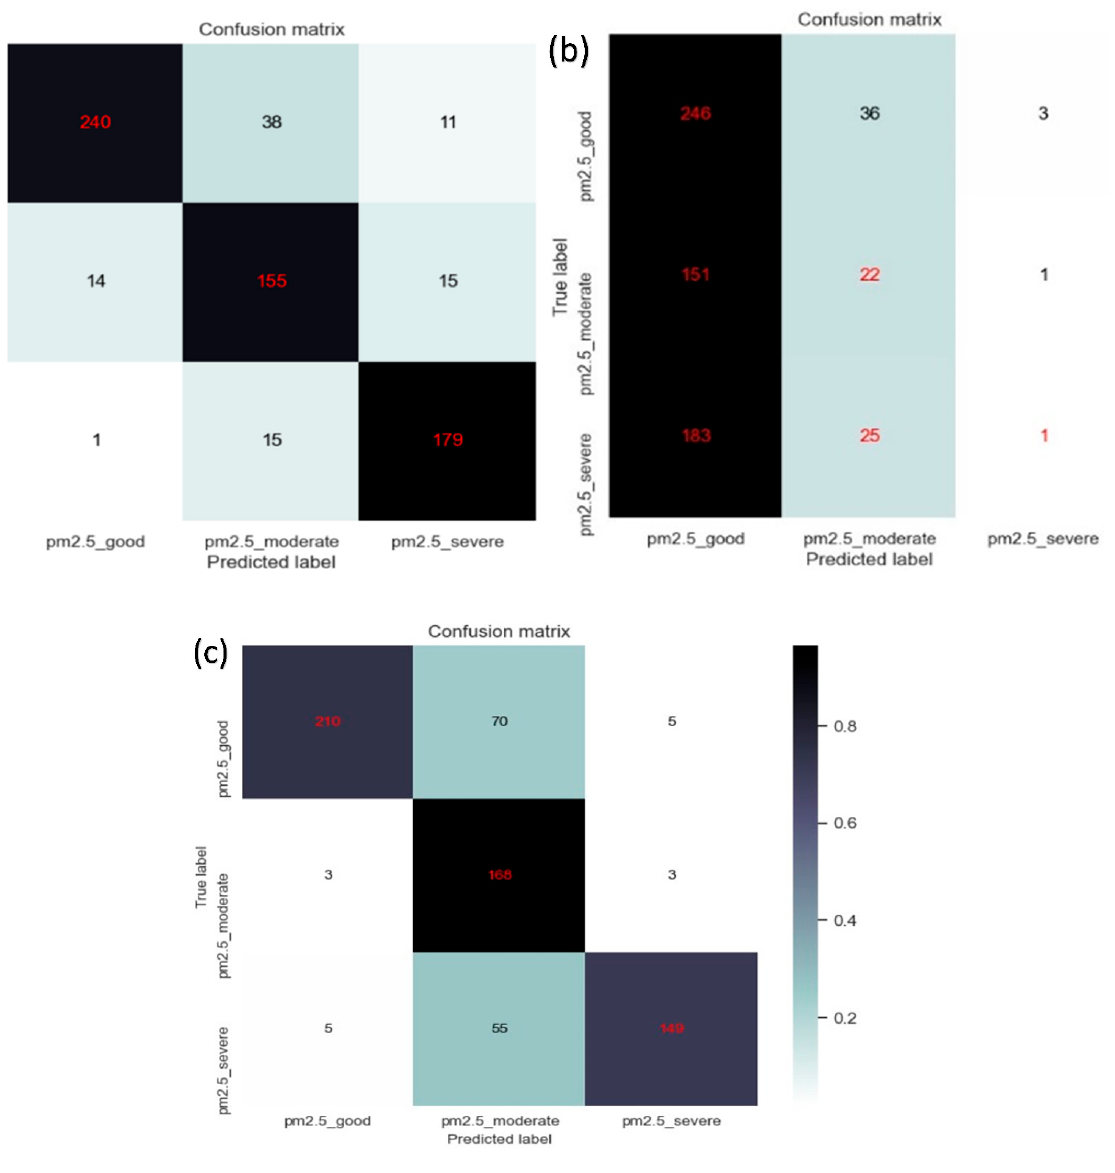
Figure 3. Confusion matrix of the methods developed. Panels ( a – c ) represent the PCA method, the 3D-CAE method, and the RGB method, respectively.